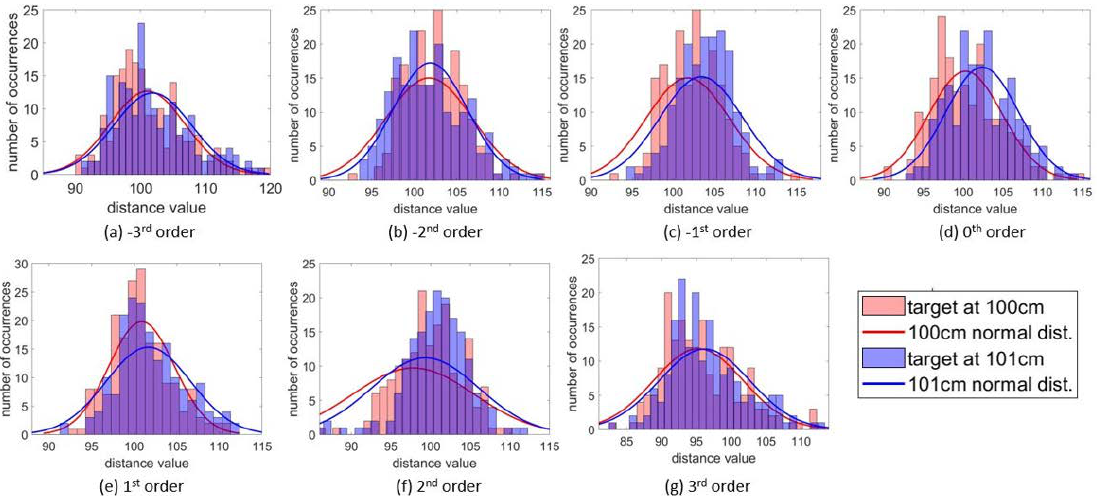
Figure 10. Histogram of distance values for ( a ) − 3rd, ( b ) − 2nd, ( c ) − 1st, ( d ) 0th, ( e ) +1st, ( f ) +2nd, and ( g ) +3rd orders. Across the 7 sub-FOVs, the distance accuracy was at least 1